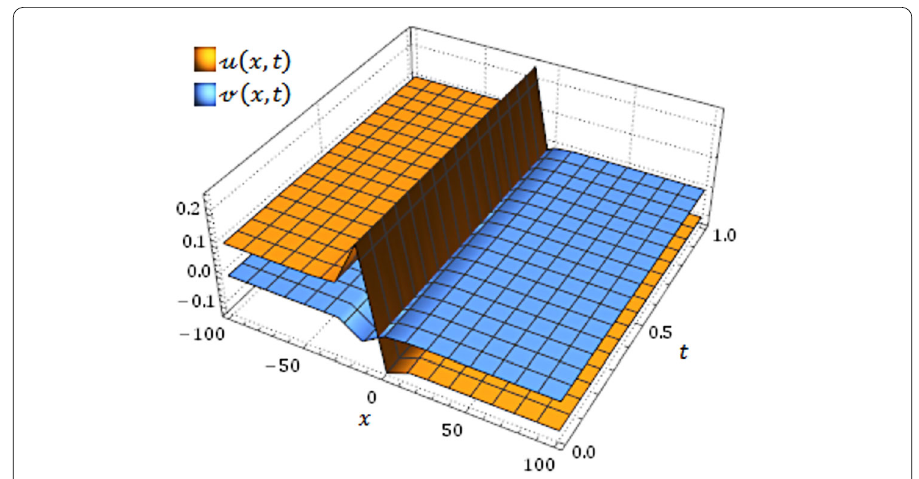
Figure 18 Nature of coupled q -HATM solutions u ( x , t ) and v ( x , t ) for Example 6.2 when at n = 1, α = 1, (cid:2) = –1, ω = 0.005, (cid:13) = 0.1 and c = 10